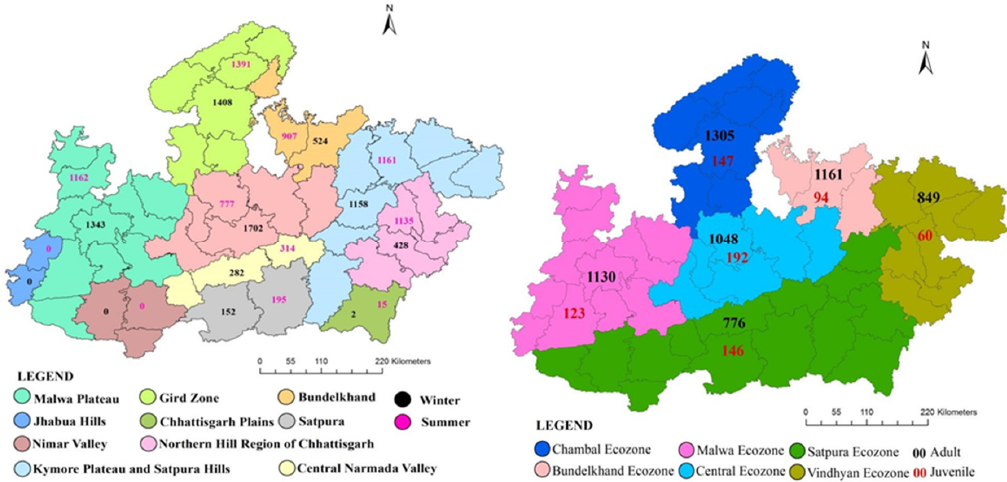
Figure 4. Winter and summer distribution of vultures population in different agro-climatic regions (left) and adults and juveniles spread in different ecozones of the study area. The Eastern side of the state has lower population (wetter areas with moist deciduous and dense forests) than the drier areas with dry deciduous and open